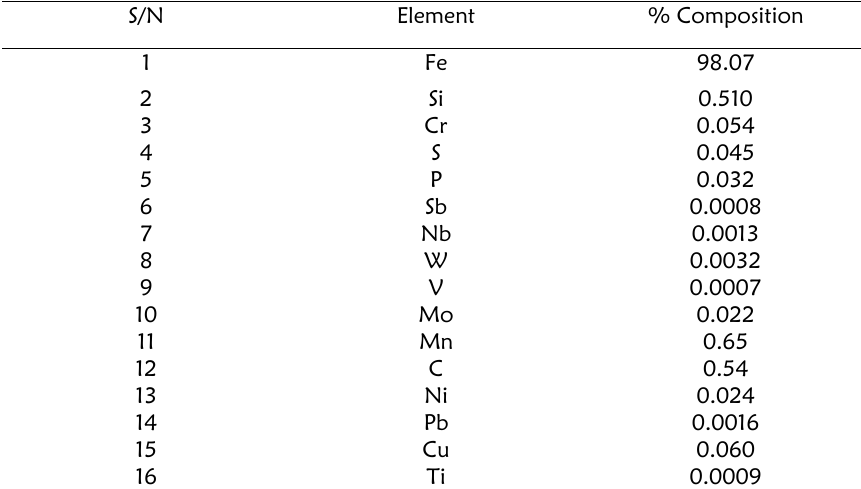
Table 1: Chemical composition of High Carbon Steel